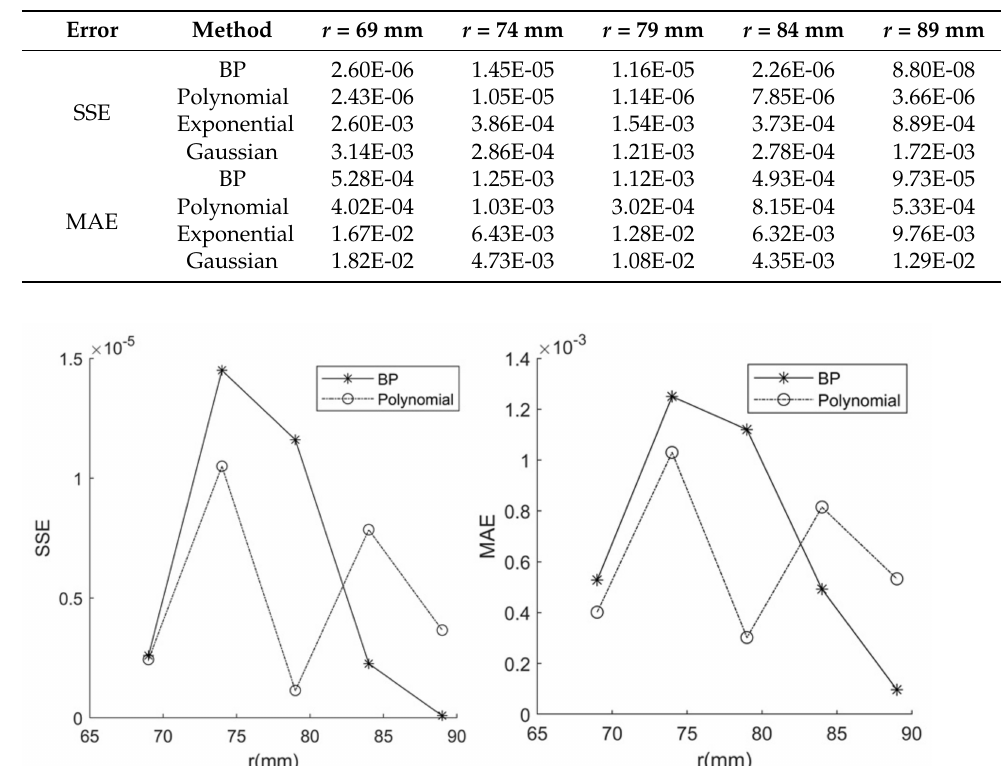
Table 5. Comparison of prediction accuracy for different methods.